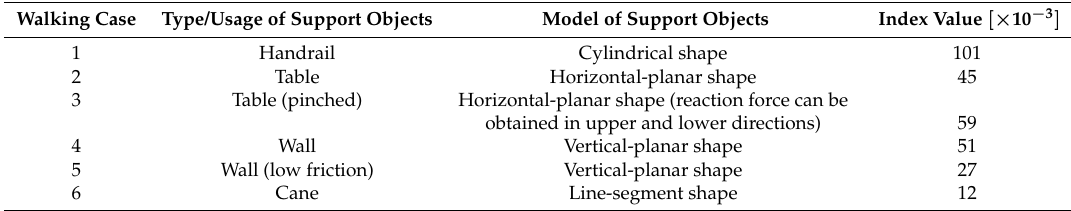
Table 3. Example of assessment of living space.